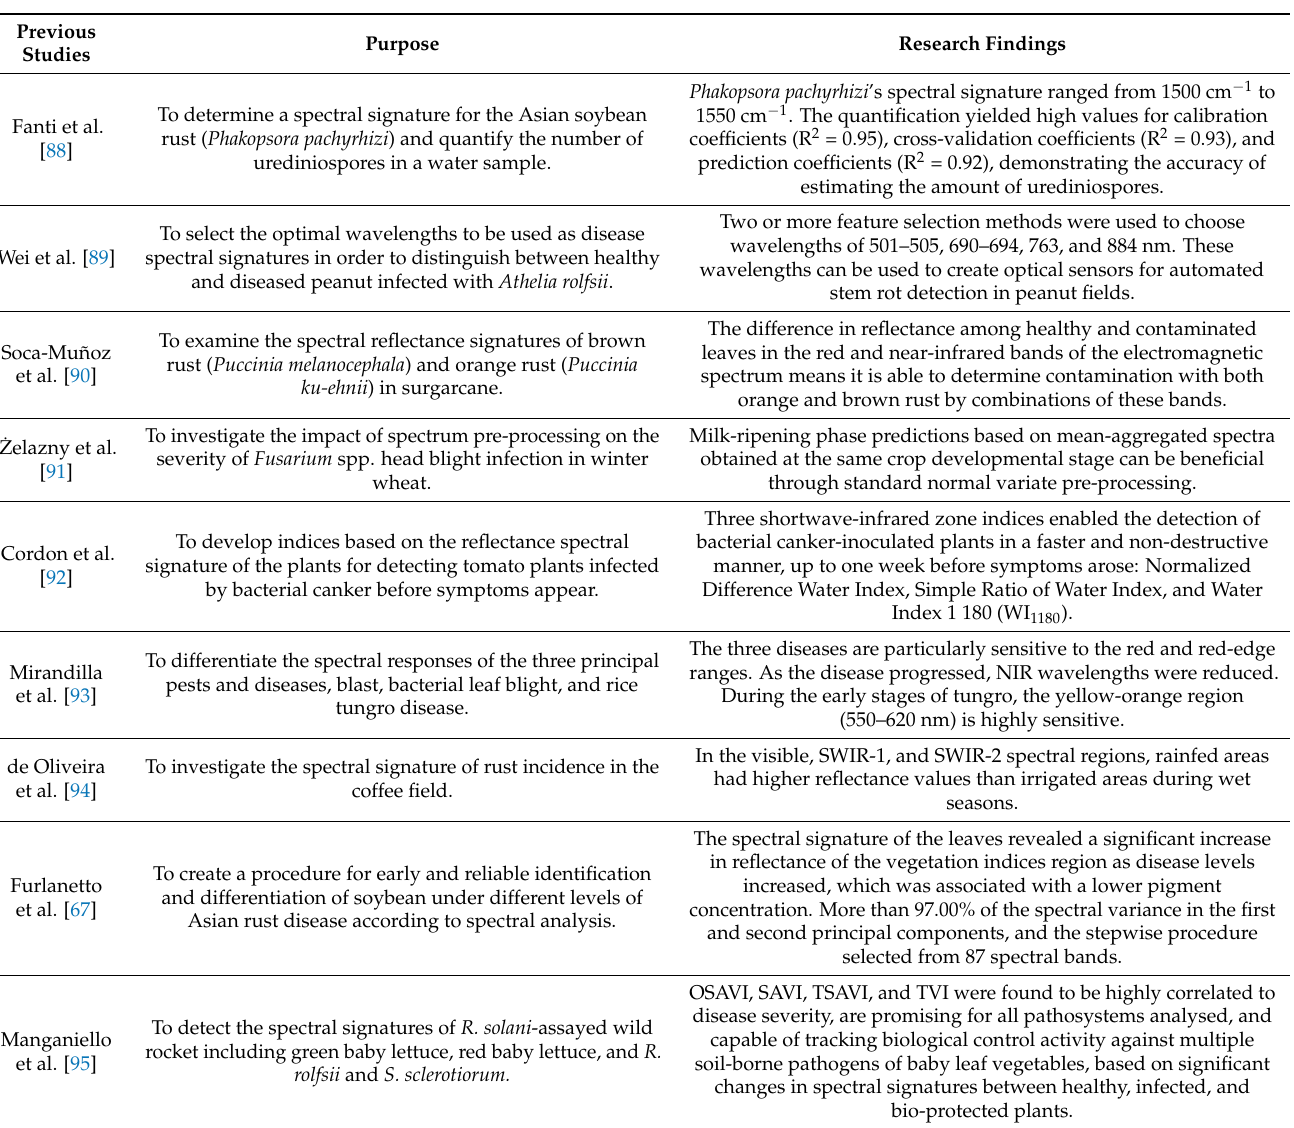
Table 3. Example of applications for spectral signature analysis in pest and disease